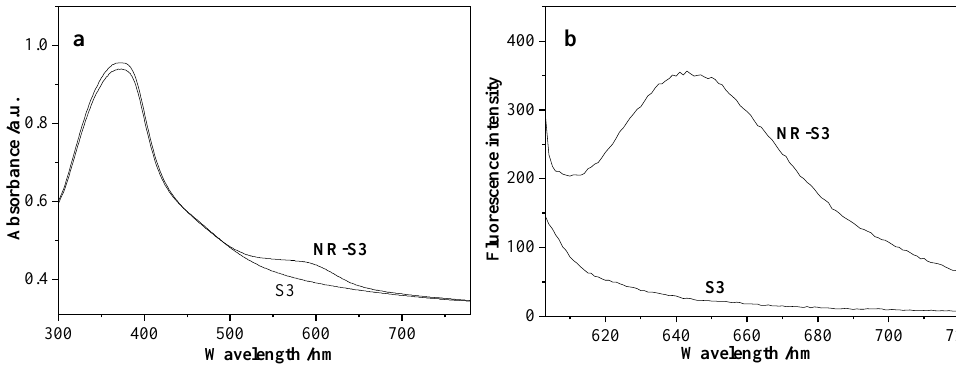
Figure 9. UV-vis spectra ( a ) and fluorescence spectra ( b ) of S3 and NR-S3 micellar solution. Nile red is a special dye molecule, which does not exhibit any fluorescence when it is soluble in water, but the fluorescence intensity remarkably increased in the hydrophobic environment, for example, inside a hydrophobic micellar core [29]. In this case, the photo-induced Nile red release of S3 micellar solution was investigated first. Figure 10a shows that the fluorescence intensity at about 645 nm was obviously decreased when NR-S3 micellar solution was exposed to UV light, and the fluorescence intensity was not changed up to 70 min, indicating the random copolymeric azo-moiety reached a photoisomerization equilibrium. Figure 10b exhibited that the fluorescence intensity basically returned to the initial value, when in NR-S3 micellar solution after exposed to the UV light for 60 min was irradiated with visible light, and the fluorescence intensity was not changed up to 60 min.